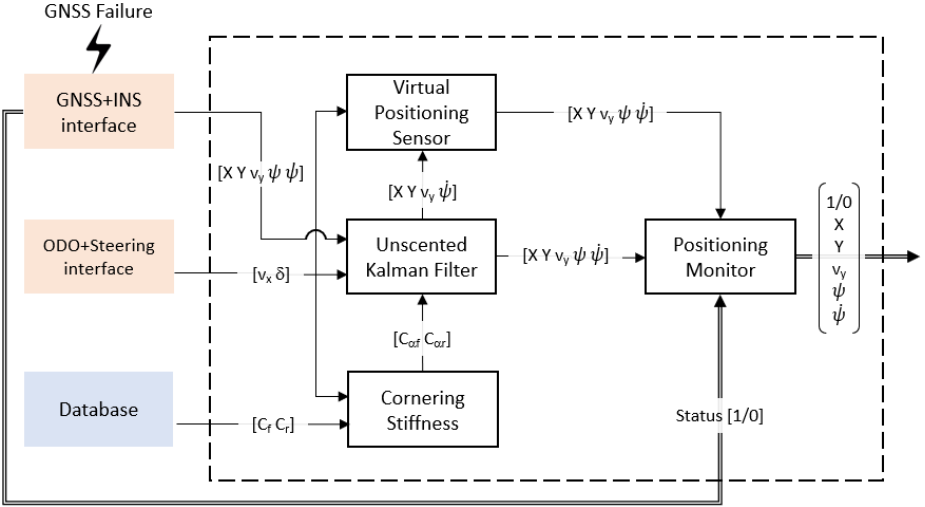
Figure 2. Flowchart on fail-operational Positioning